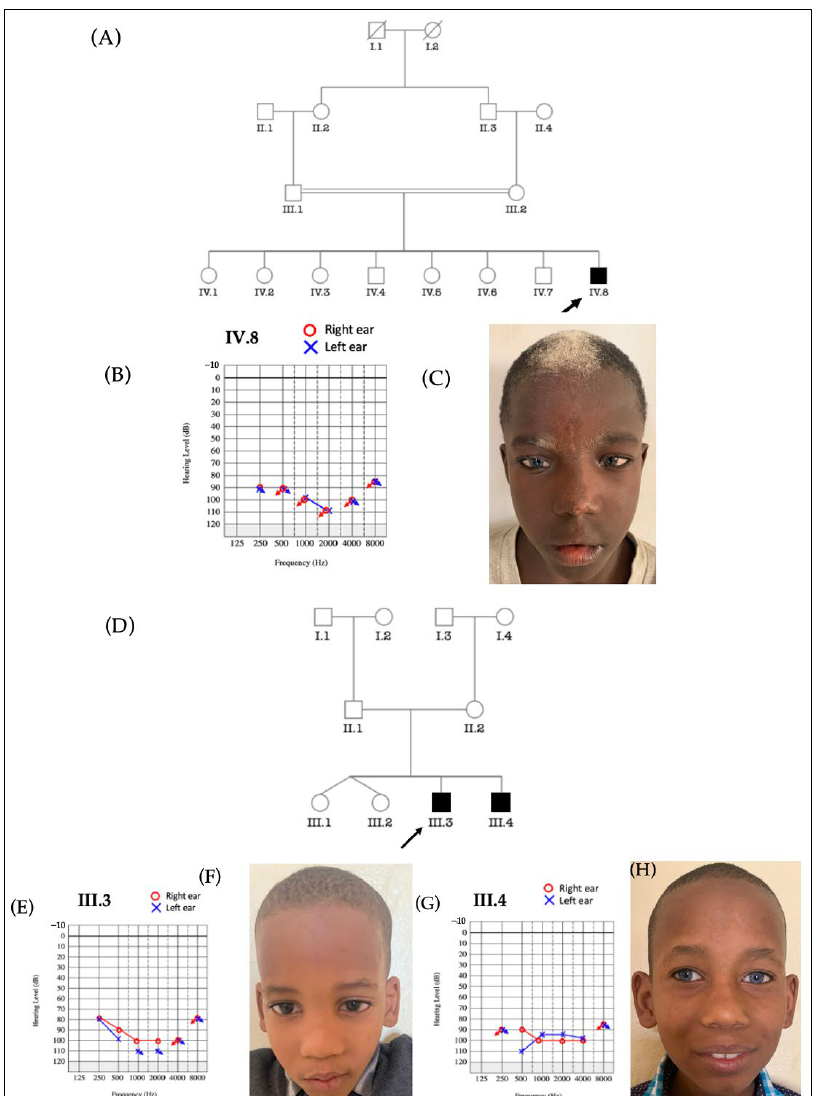
Figure 3. Two families with Waardenburg syndrome type 2. In the first family ( A ) the proband ( C ) exhibited white forelock, sapphire blue eyes, and hypopigmented skin patches associated with profound sensorineural HI ( B ). In the second family ( D ), the proband ( F ) showed light skin, white hair, and profound HI ( E ), while his brother ( H ) exhibited sapphire blue eyes and light skin associated with profound HI ( G ).